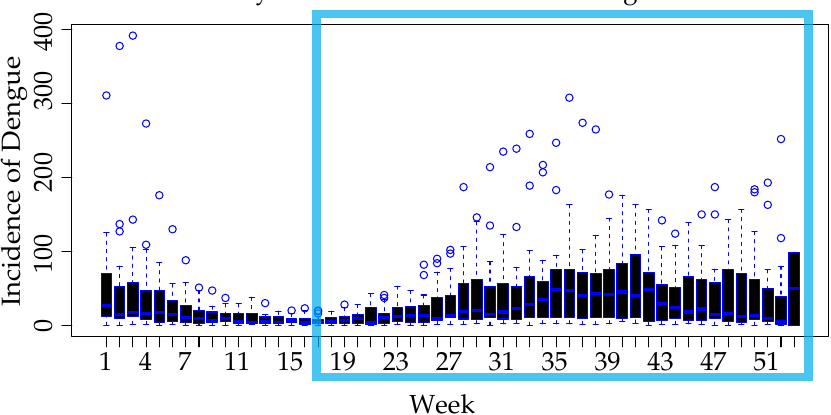
Figure 6. Weekly distribution of confirmed dengue cases, grouped by weeks along the study